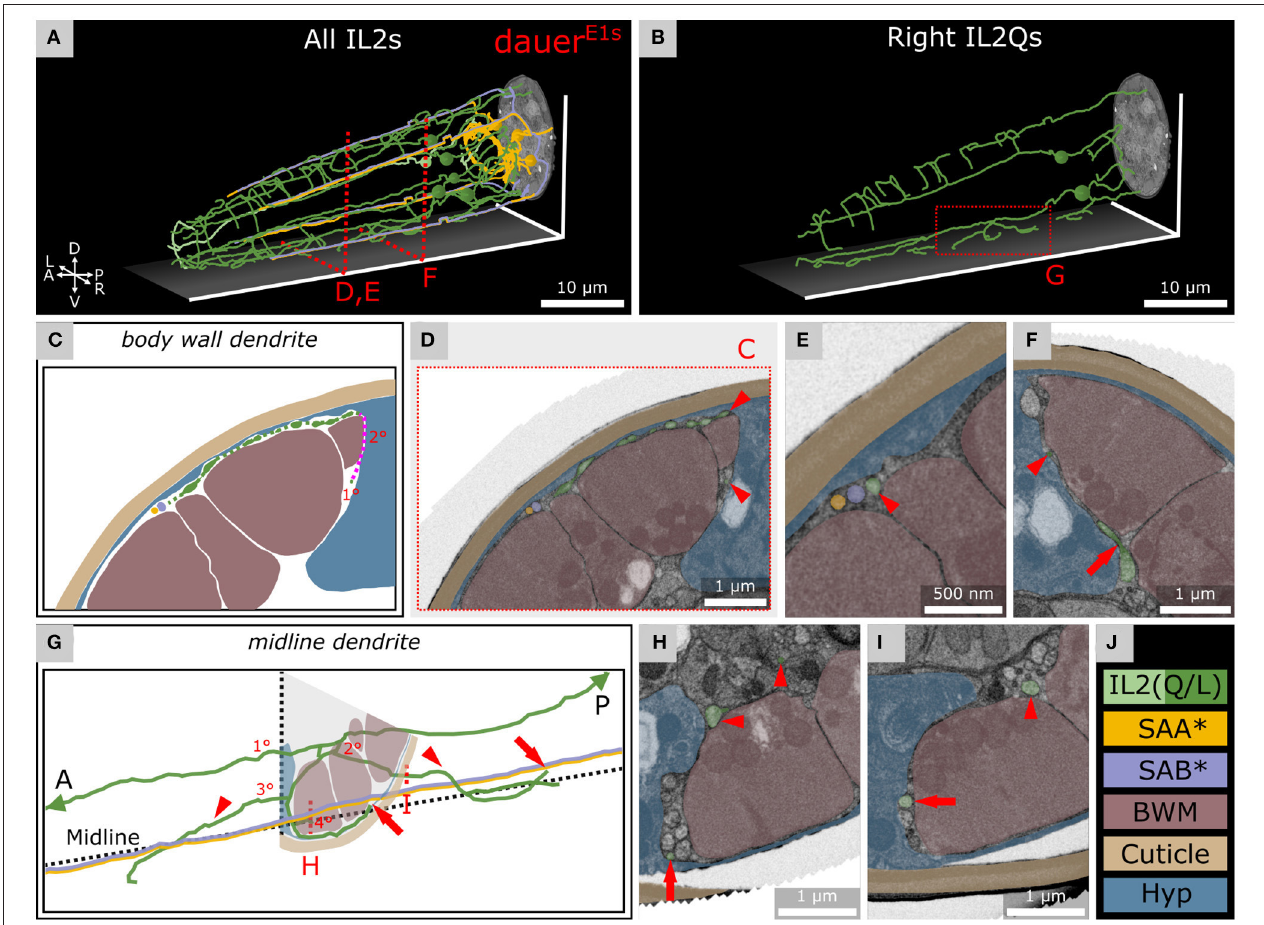
FIGURE 4 | IL2Q neurons extend dauer-specific highly ordered branches all along their 1 ◦ dendrites, some of which come into close contact with SAA and SAB neurons. (A) Skeleton tracing of all six IL2 neurons, four SAA, and three SAB neurons in the anterior dauer larva. Spheres indicate the respective somas. Only IL2Q dendrites extend multiple branches along their length. IL2L neurons show anterior crown-like dendrites only. (B) Skeleton tracing of the right IL2Q neurons from (A) , as an example for IL2Q. (C) Scheme of an exemplary body wall dendrite of IL2QDL from D originating from a radial dendrite which is schematically delineated (magenta). (D) Transverse FIB-SEM section through the body wall dendrite of IL2QDL (arrowheads) used for the scheme in C. (E) IL2QDL dendritic branch (arrowhead) from D reaching the SABD neuron (300nm anterior to D). (F) Example of a radial dendrite of IL2QDR (arrowhead) one section before its branching point (arrow). (G) Scheme of IL2QVR dendrite branching indicated in (B) following the midline in both directions (arrowheads) and representing highly ordered branching up to 4 ◦ dendrite including body wall dendrites reaching neurons in the sub-lateral cord (arrows). Note that the identity of ventral SAB vs. SAA projections could not be clarified in our data set (*). (H) Transverse FIB-SEM section through IL2QVR (arrowheads) 4 ◦ dendrite (arrow). (I) Transverse FIB-SEM section through the IL2QVR (arrowhead) 2 ◦ dendrite (arrow) projecting posteriorly along the midline. (J) Names and color code of cells or structures